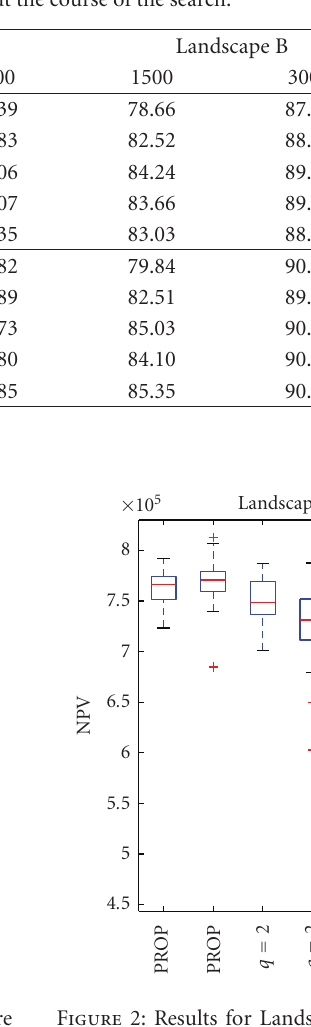
Table 3: Best solutions for landscapes A, B, and C. We present the best solution in terms of percent of trivial upper bound (TUB), for each selection/penalty combination. The secondary column heading represents the maximum number of generations. PROP: Proportional selection; BIN DT: Binary, deterministic tournament; 7 DT: A deterministic tournament with 7 competitors; U(2, 10) DT: A deterministic tournament with the number of competitors sampled from a uniform distribution on the range (2, 10); 2–7 DT: A deterministic tournament where the number of competitors increases from 2 to 7 throughout the course of the search.